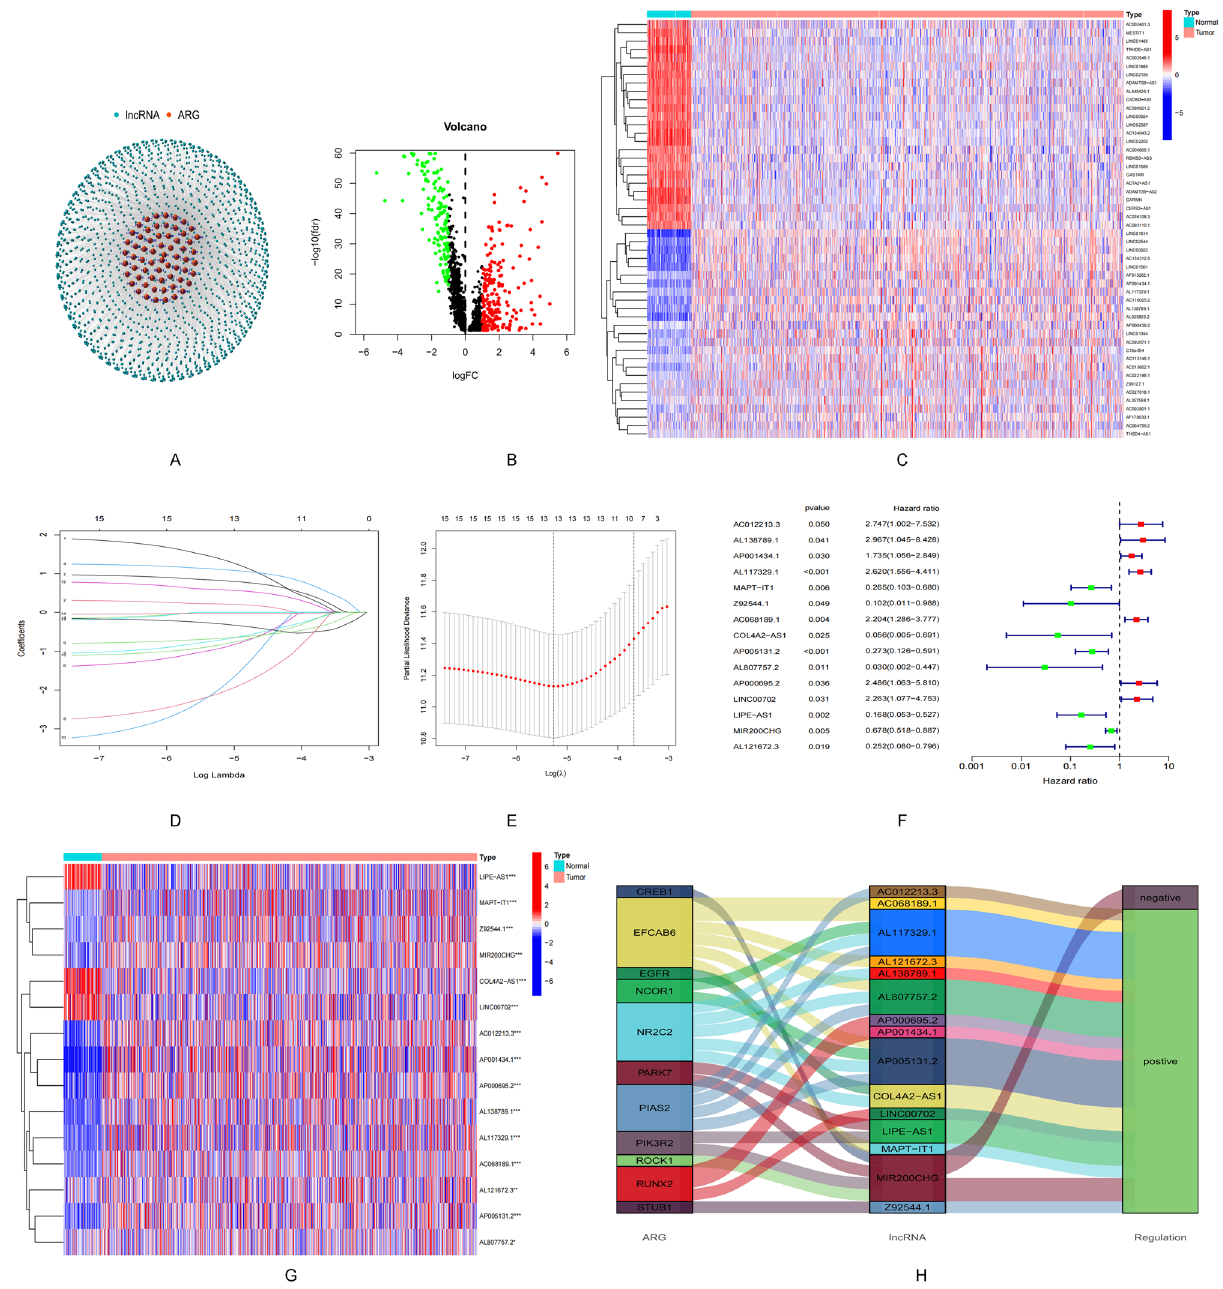
coefficient profiles of 15 ARSP-lncRNAs. ( F ) Prognostic lncRNA extracted by univariate Cox regression analysis. ( G ) Expression profiles of 15 prognostic lncRNAs. ( H ) Sankey diagram of ARPS genes and related